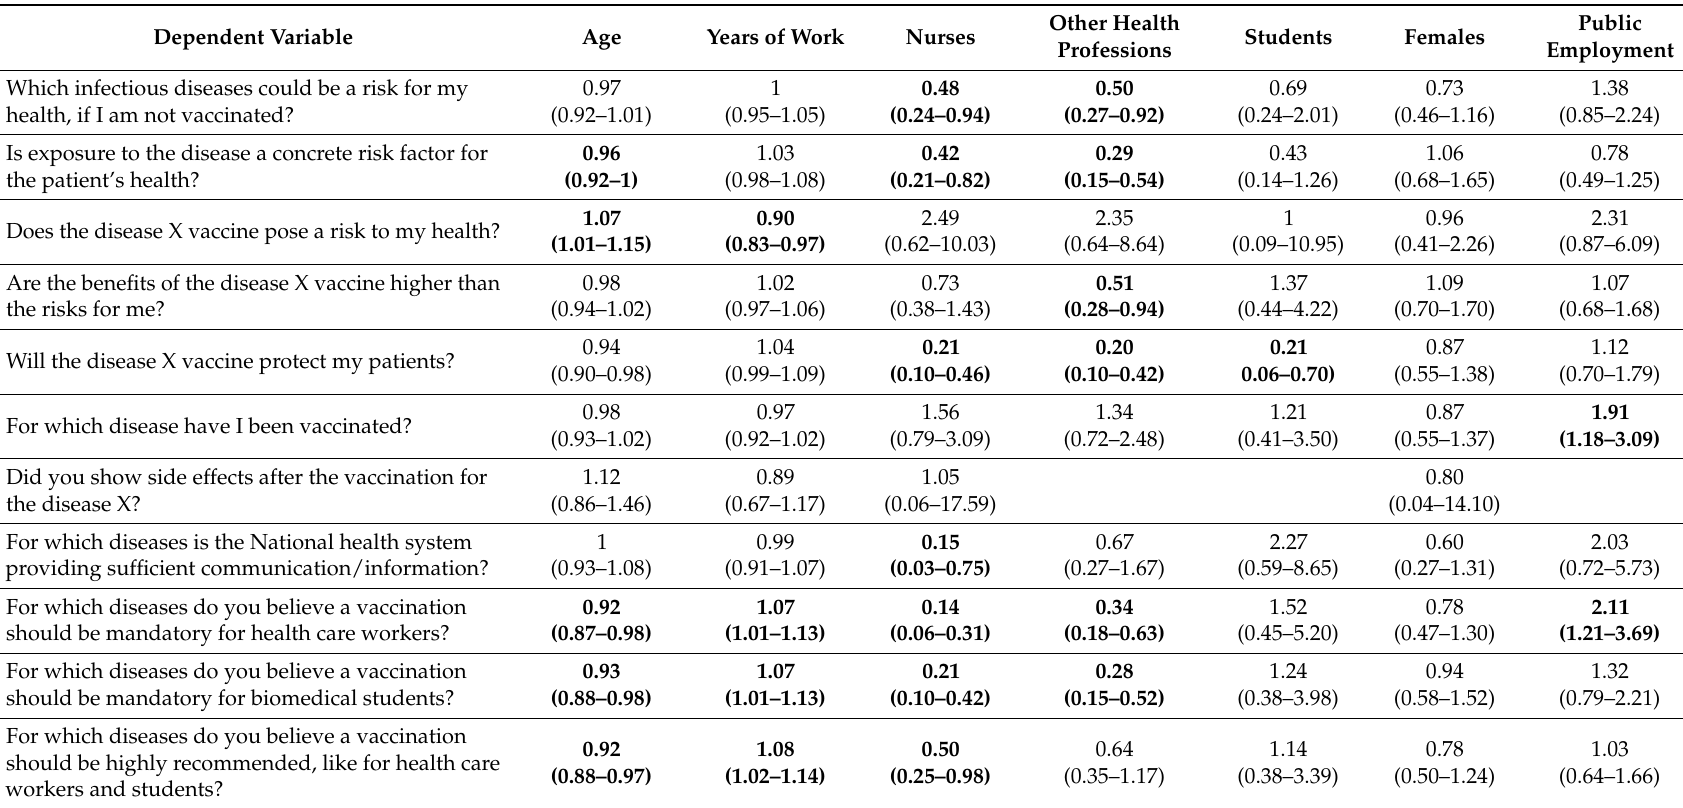
Table 7. Results of the multivariate analysis considering